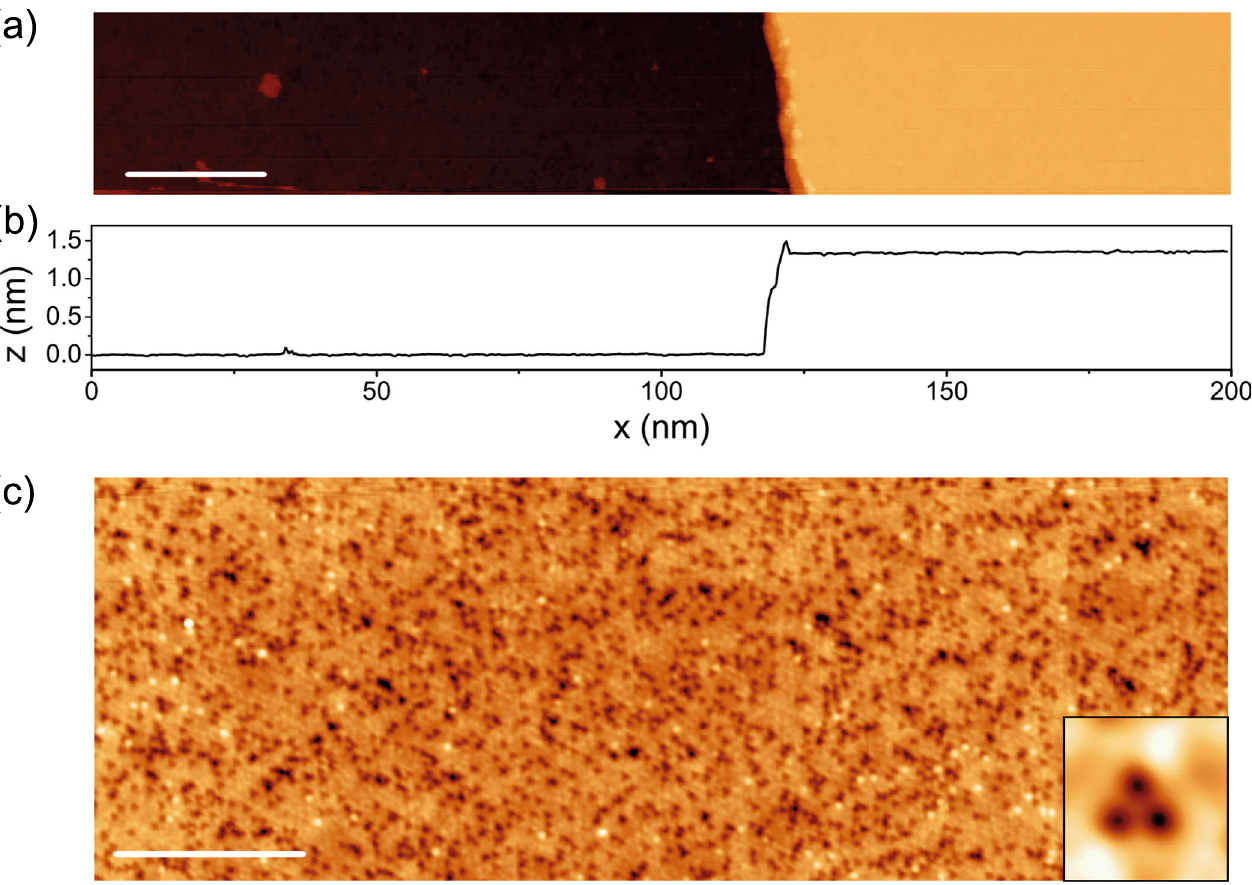
Fig. 2 STM images of the MnBi 2 Te 4 surface. Large scale STM topographic images of the MnBi 2 Te 4 Te-terminated (0001) surface after in situ cleavage showing a fl at terraces separated by an SL thick step (2 V and 0.5 nA, scale bar 25 nm) and b its corresponding line pro fi le. c STM image of a representative area far from the step where the characteristic density of surface defects can be observed (1 V and 0.1 nA, scale bar 25 nm). Inset: Zoom of 2.5 nm 2 of one of the triangular-shaped defects taken at 1 V and 0.1